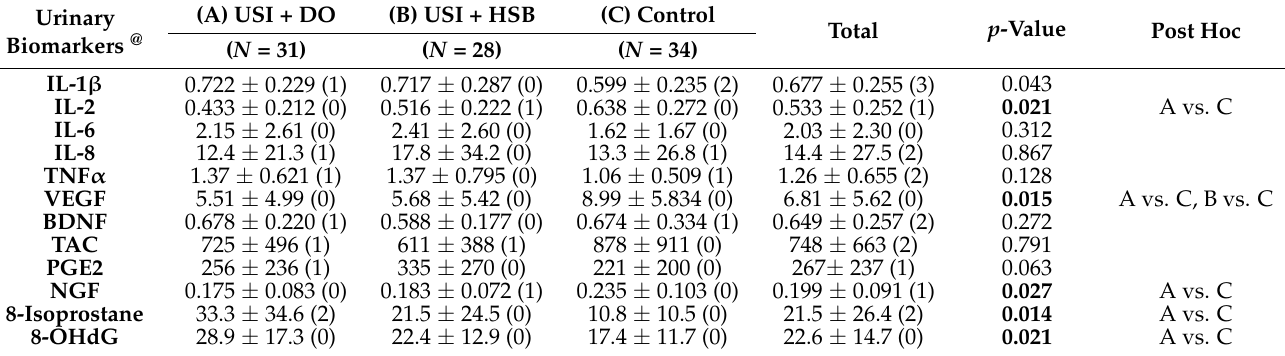
Table 2. Levels of urinary biomarkers among the USI and DO, USI and HSB, and control groups.